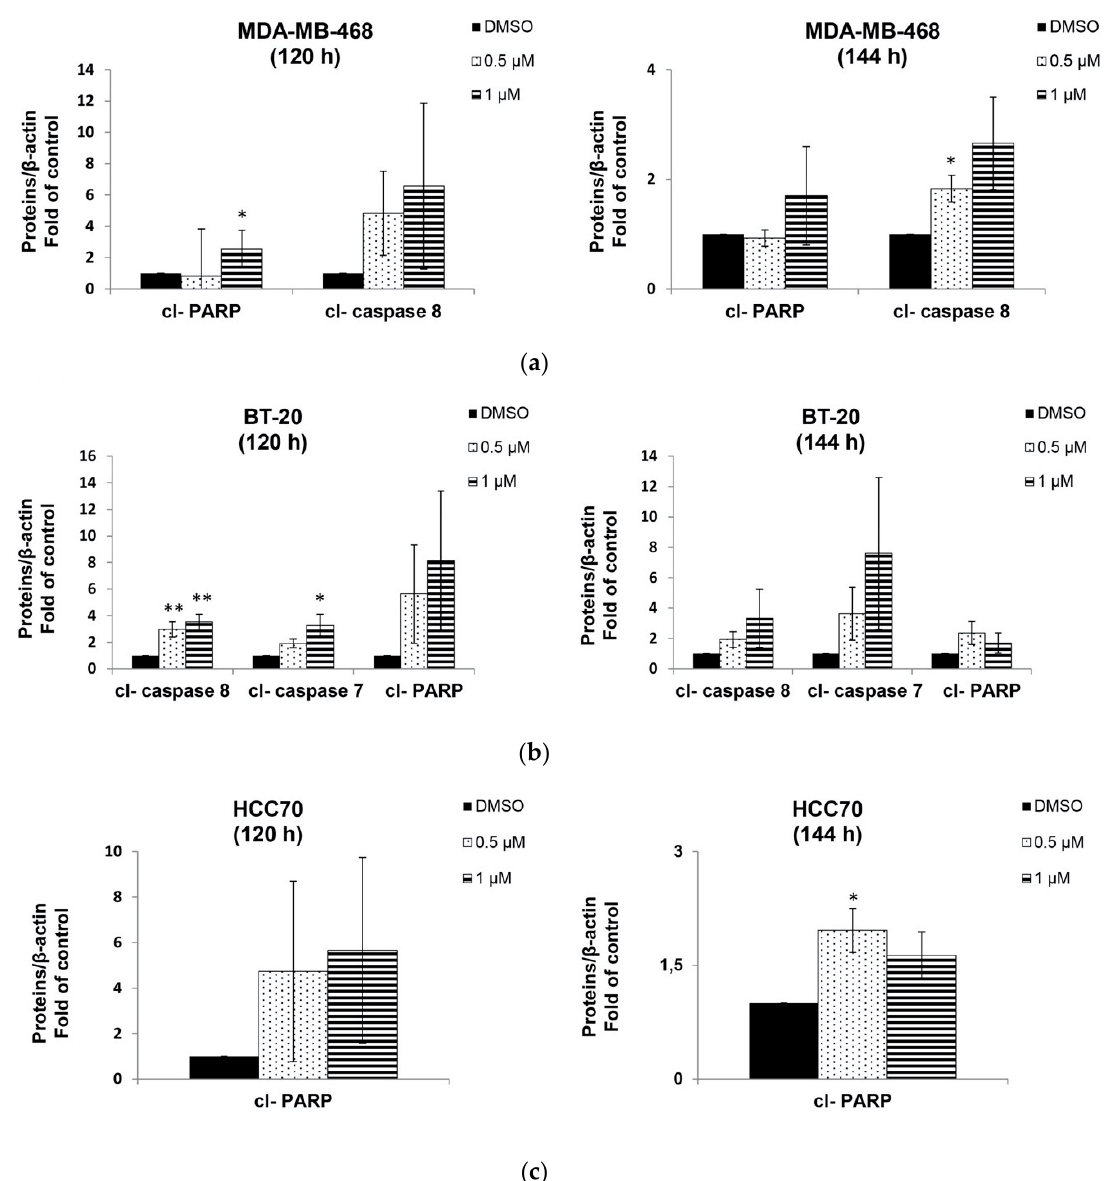
Figure 8. Fold of control of the western blot apoptosis related proteins expression upon berberine’s treatment at 120 h and 144 h: cl-PARP, cl-caspase 7 and cl-caspase 8. ( a ) MDA-MB-468, ( b ) BT-20 and ( c ) HCC70. ±SD of three independent experiments, * p < 0.05, ** p < 0.01 and *** p < 0.001 compared to DMSO. Berb—Berberine.